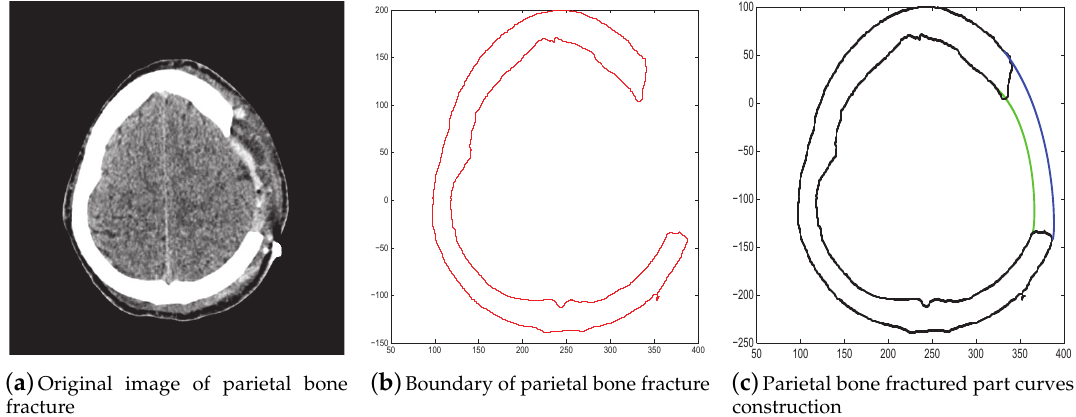
Figure 15. Construction of parietal bone fractured part curves using rational cubic Ball curves.